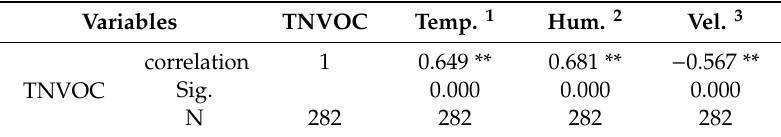
Table 2. Correlation between NVOCs and the Betula platyphylla forest microclimate. Variables